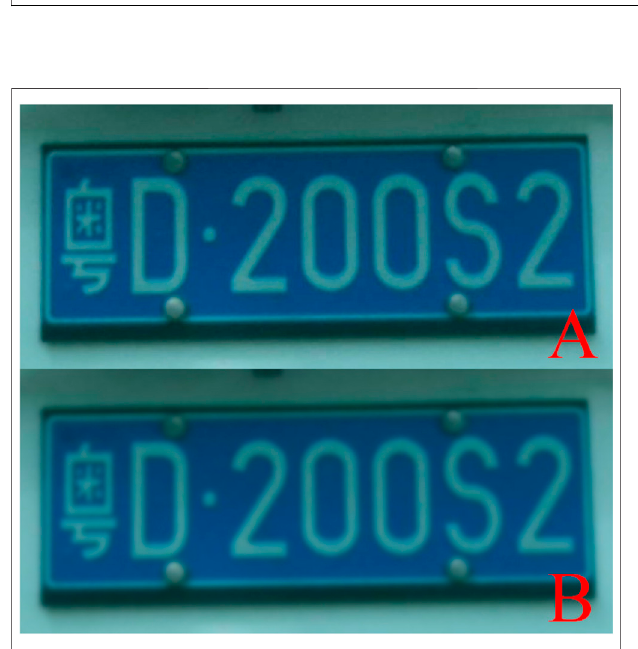
FIGURE 4 | | Comparison images of correction. (A) is the left image before calibration, and (B) is the right image before calibration. (C) is the left image after calibration, and (D) is the right image after calibration.